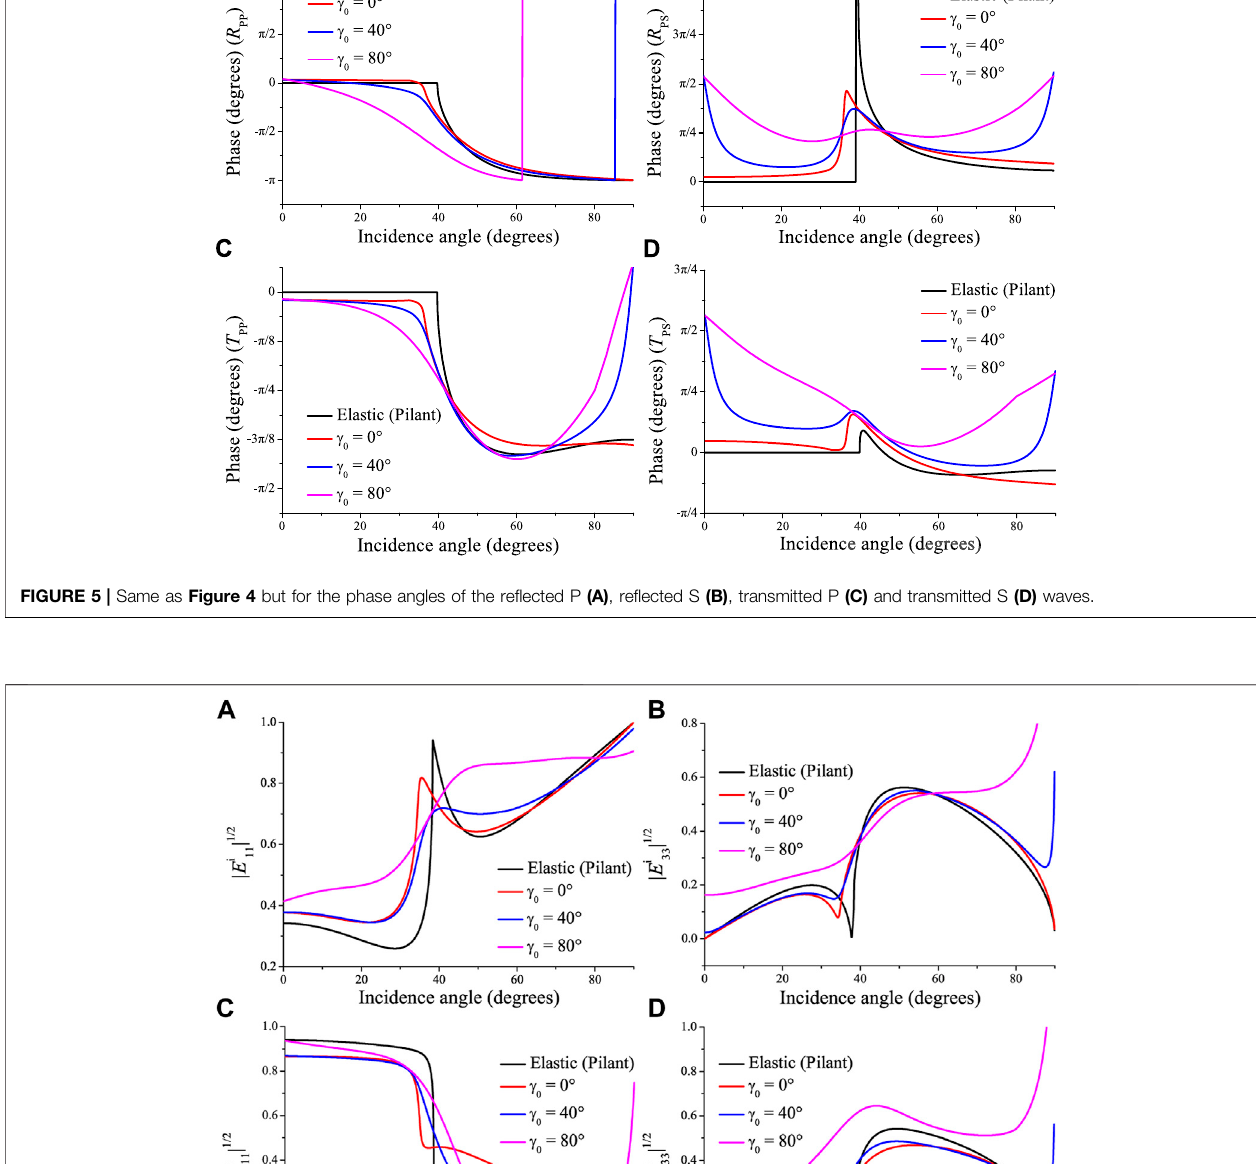
Frontiers in Earth Science |